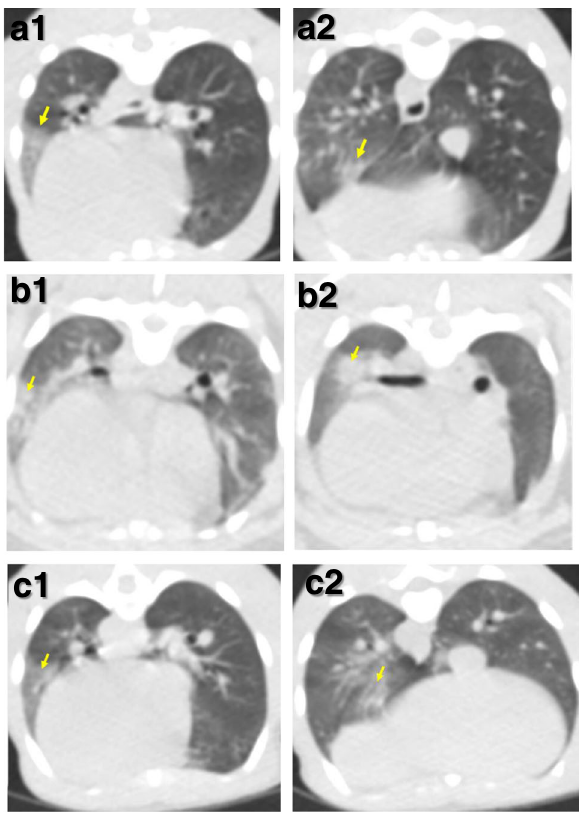
Fig. 2 CTscan images from cynomolgus and rhesus macaques infected with SARS-CoV-2 and culled at 18 days post challenge. Images constructed from CT scans collected 18 days after challenge with SARS- CoV-2 showing pulmonary abnormalities in two cynomolgus ( a , b ) and one rhesus macaque ( c ). Arrows in images ( a1 ), ( b1 ) and ( c1 ) indicate areas of peripheral ground glass opaci fi cation. Arrows in images ( a2 ) and ( c2 ) indicate areas of ground glass opaci fi cation and arrow in image ( b2 ) indicates an area of consolidation. Images from a second rhesus macaque did not have abnormal